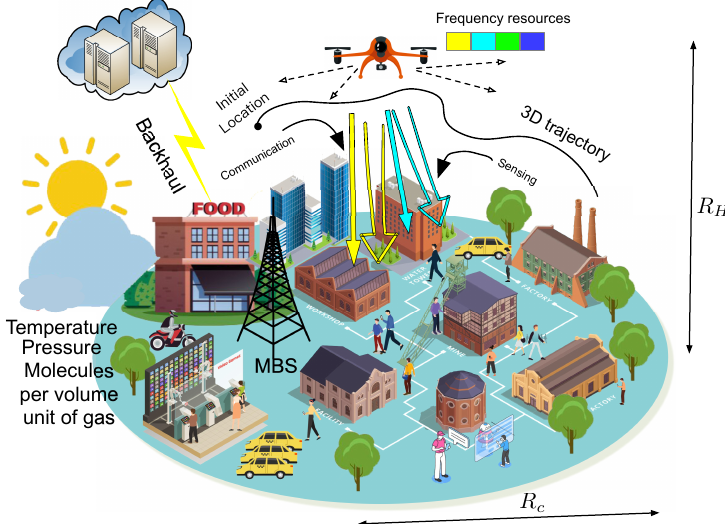
Figure 2. Illustration of a terahertz band integrated sensing and communications